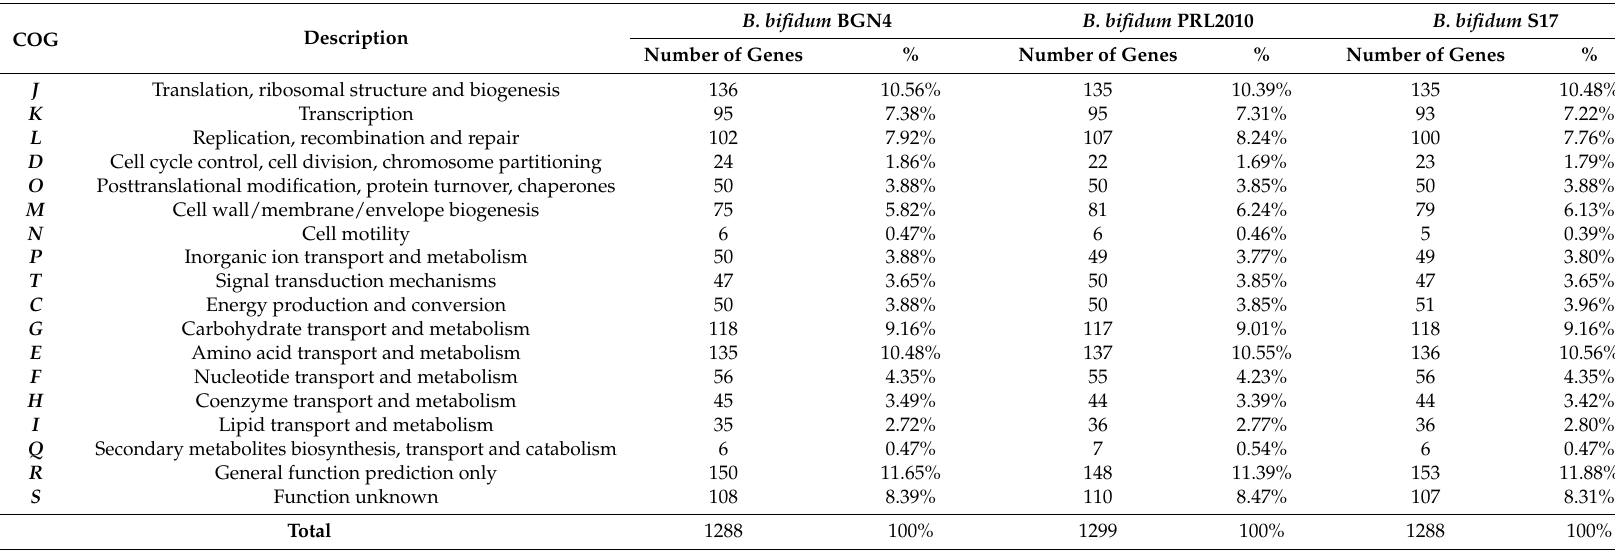
Table 3. Summary of genome analysis comparing COGs of three B. bifidum strains (analyzed by the authors based on NCBI